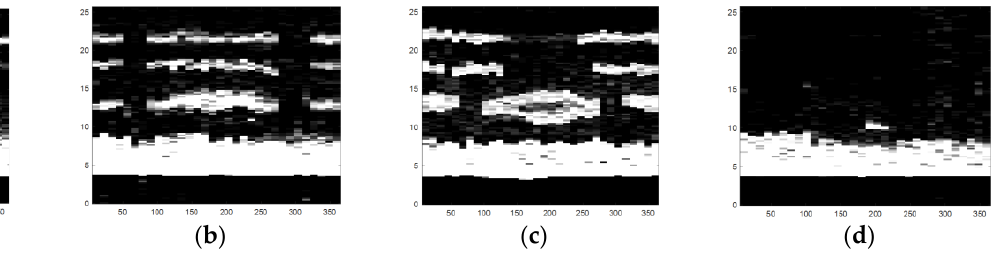
Figure 11. Grayscale images of four types of defects: ( a ) small crack, ( b ) transverse crack, ( c ) hole defect, and ( d ) chapped defect.